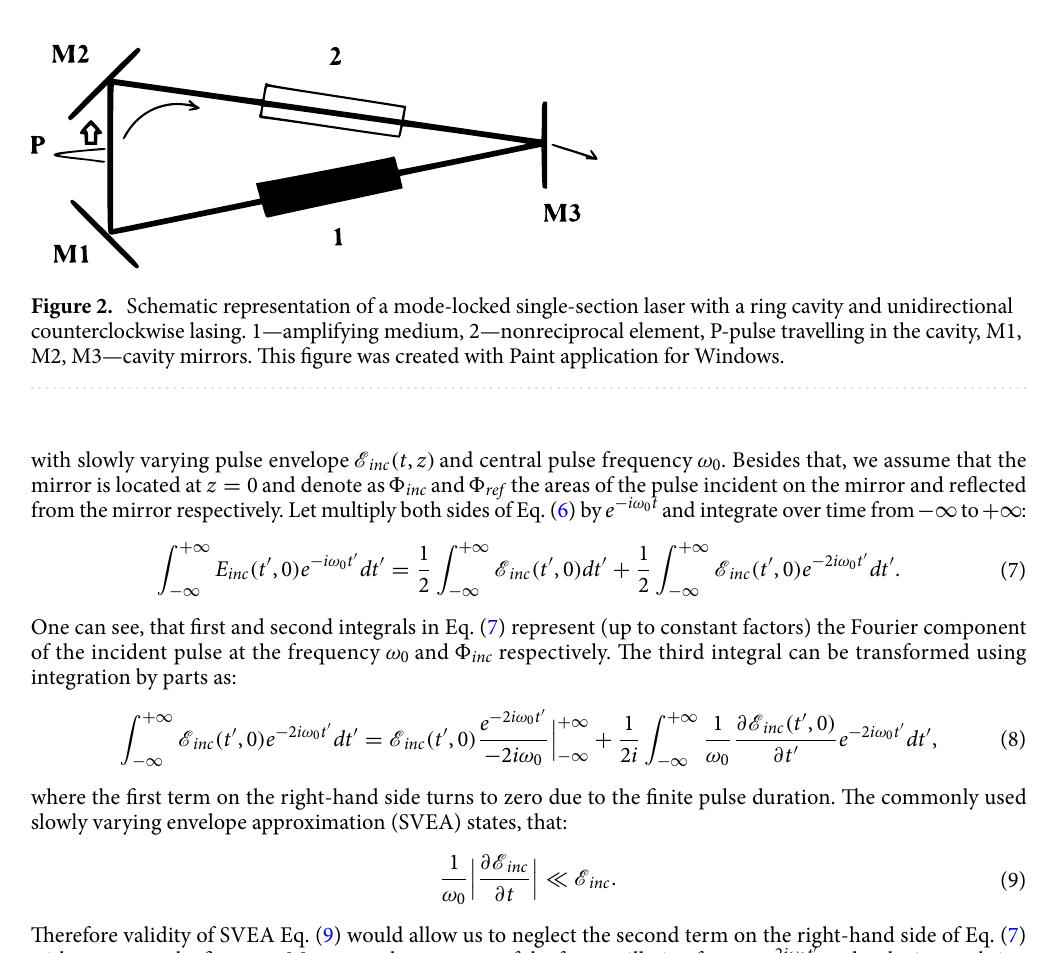
Figure 1. Branches of the solution of Eq. (2) for the amplifier for different initial pulse areas � 0 = 0.2 π (curve 1 g ) and � 0 = 1.8 π (curve 2 g ) for | α 0 | = 10 cm − mathw orks.com).